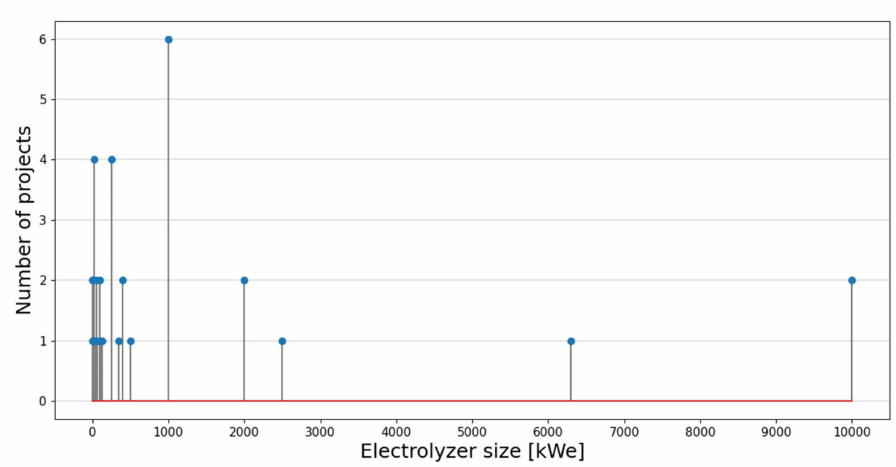
Figure 3. Number of power-to-gas projects per electrolyzer size.